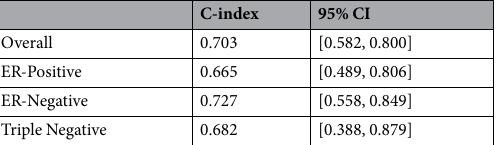
Table 2. Performance of M2EFM on Kao Samples by ER and Triple Negative Status.